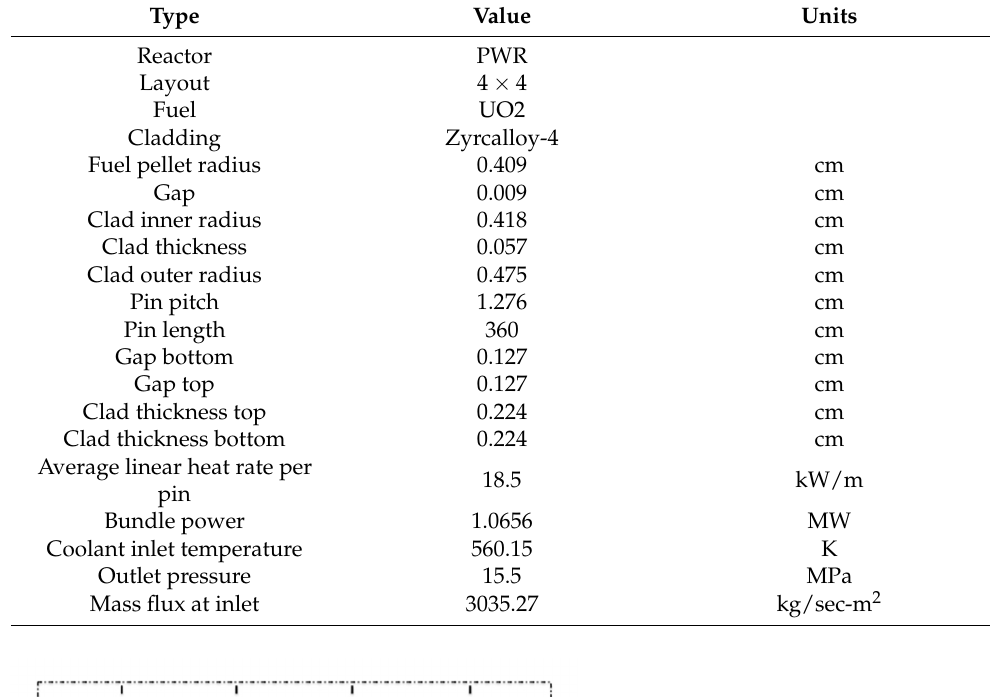
Table 3. 4 × 4 PWR sub-assembly specifications.